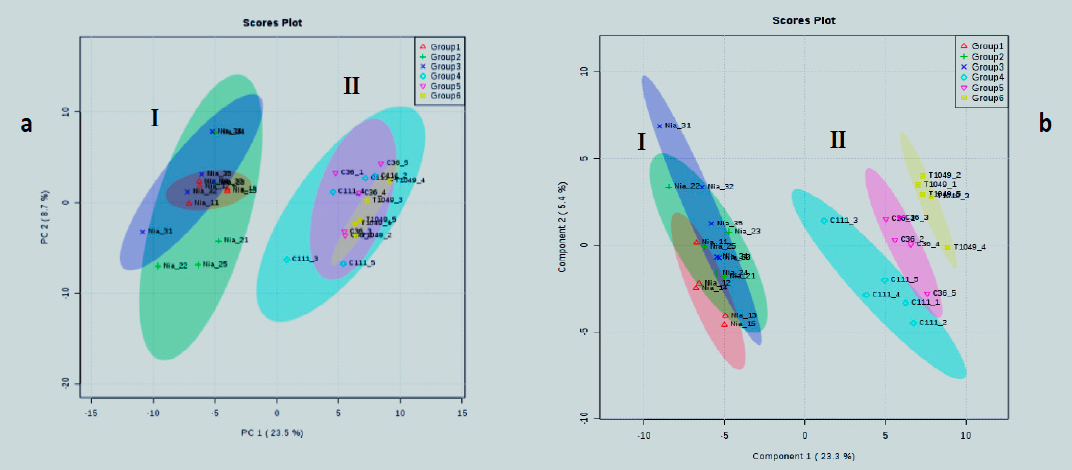
Figure 4. Multivariate classification of Nigerian Coffea canephora coffee genotypes. ( a ) Principal Component Analysis (PCA) and ( b ) Partial Least Squared (PLS) Analysis. PLS is a supervised method that minimizes within group variability and maximizes intergroup variability to achieve the greatest separation (discrimination) among groups.